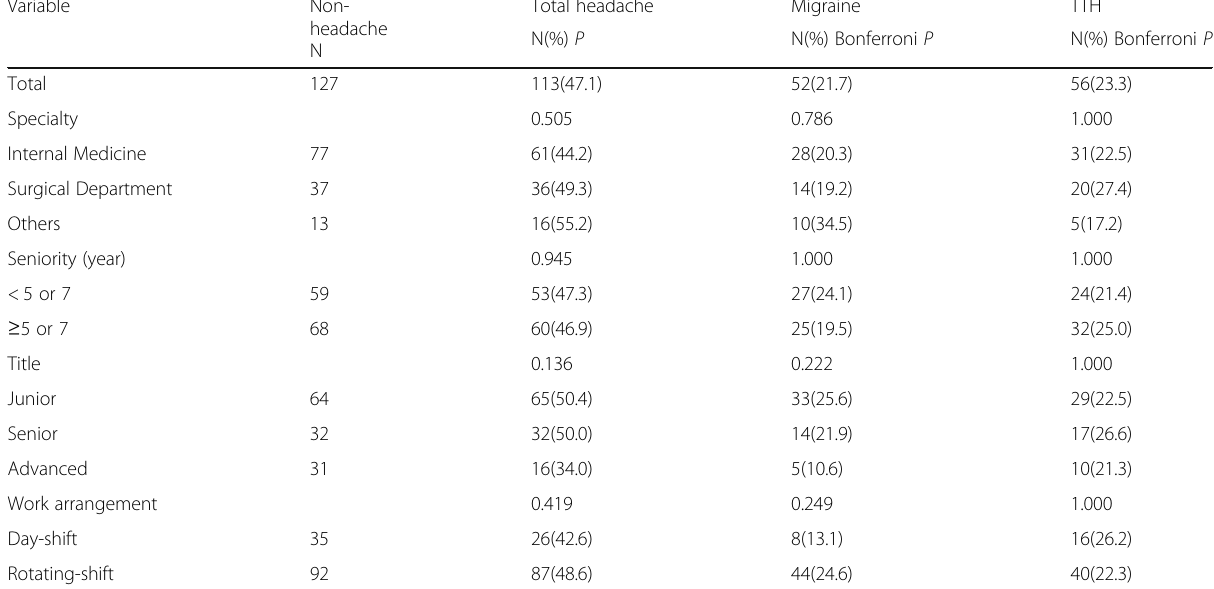
Table 3 The occupational characteristics comparisons between different types of headache and non-headache among doctors